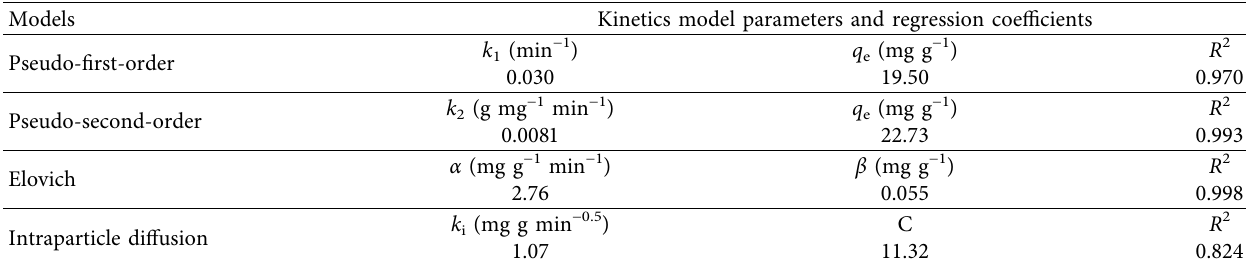
3 O 4 composite.